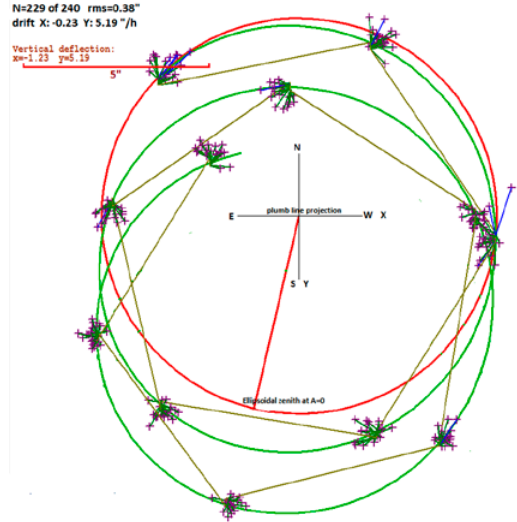
Fig. 7. Observation session results. Corrected frame zenith positions in CCD coordinate system, approximated by a circle, linearly moving in time. Vertical deflection value outlined in topocentric system (view